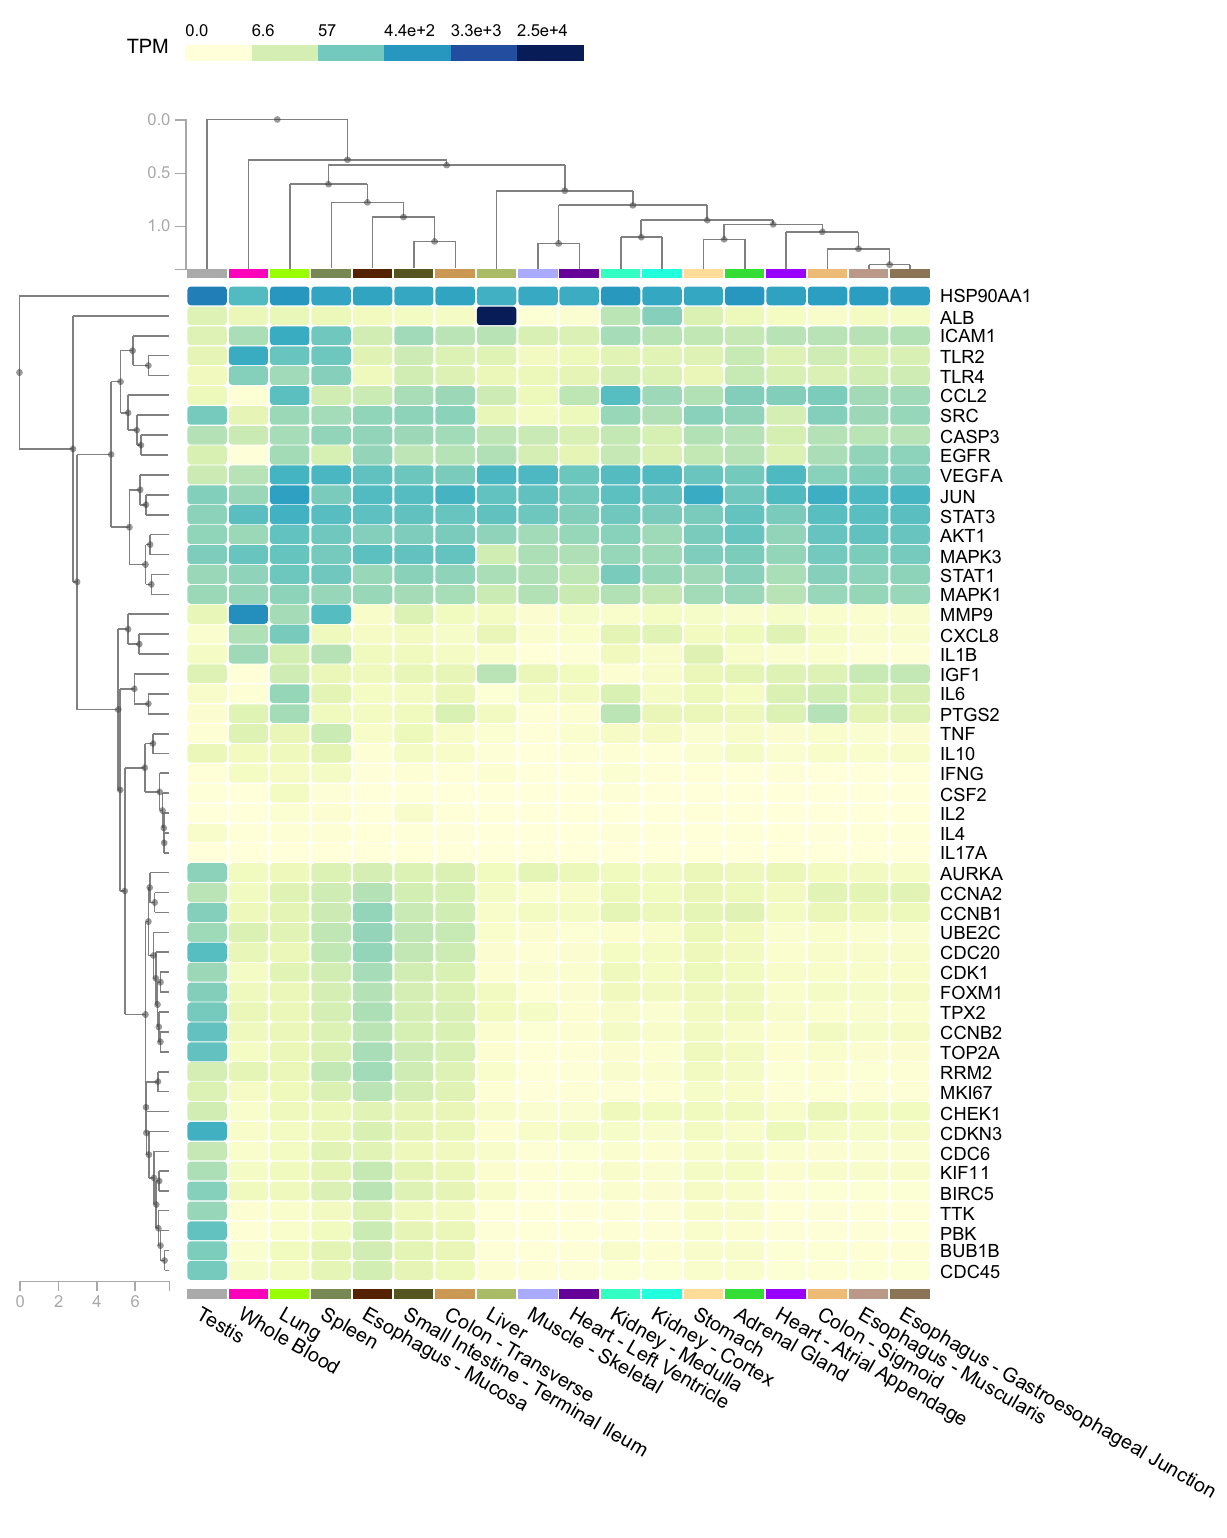
FIGURE 8 | The heat map shows the correlation between different samples and factors. Columns represent genes, rows represent tissues, and colors represent the level of enrichment, whereby a darker color indicates a more signi fi cant gene in corresponding